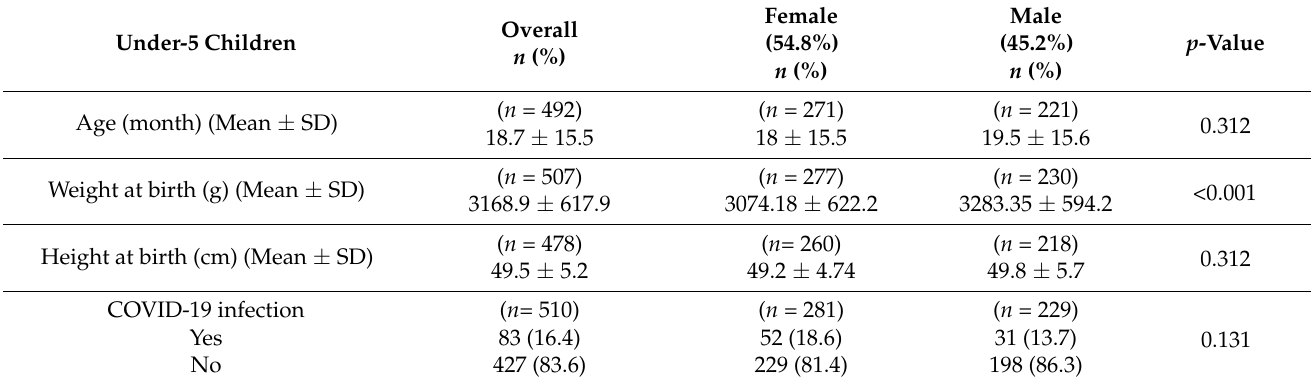
Table 2. Characteristics of under-5 years children in this